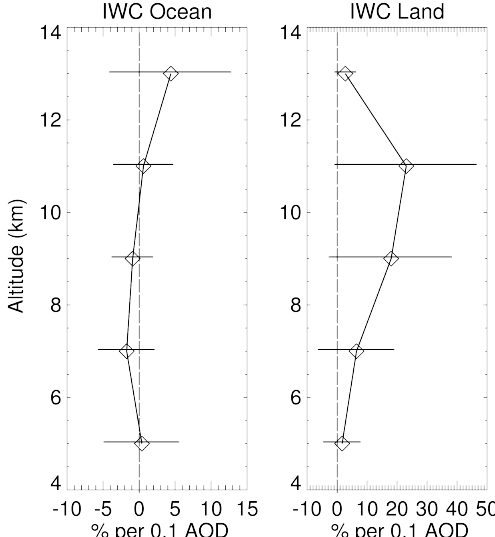
Figure 9. Vertical profiles of the means of the PDFs of IWCreg derivatives for individual regions and seasons based upon DAR- DAR IWC profiles, and MODIS AOD data for the “all AOD” case. Mean 95% confidence (2 σ) limits are indicated by the horizontal lines. The symbol at 5km denotes the average for the 5–7km alti- tude